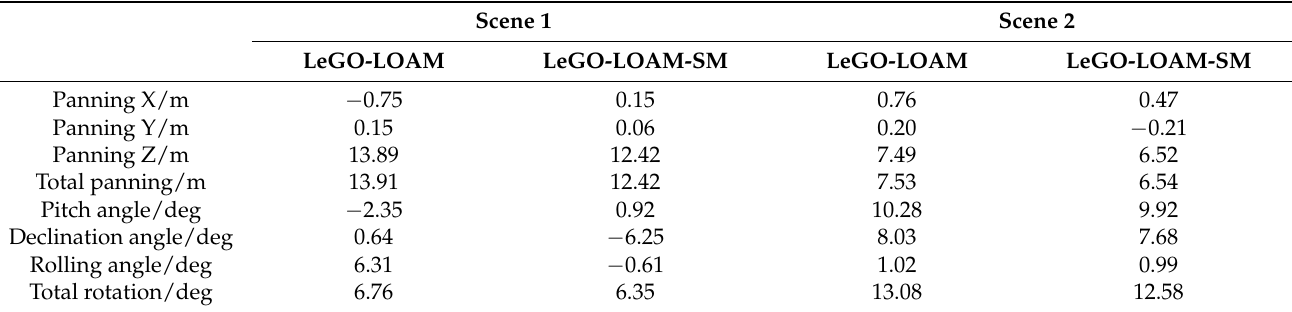
Table 3. Relative pose estimation error of LeGO-LOAM and LeGO-LOAM-SM in the scenes of the underground parking lot and the looped